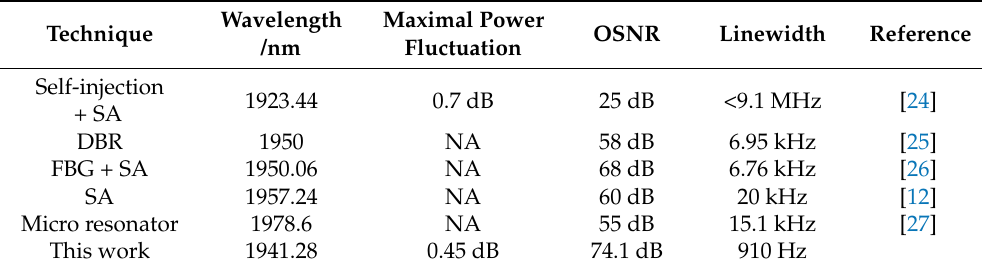
Table 1. Wavelength, Maximal power, OSNR comparison of SLM TDFL based on different